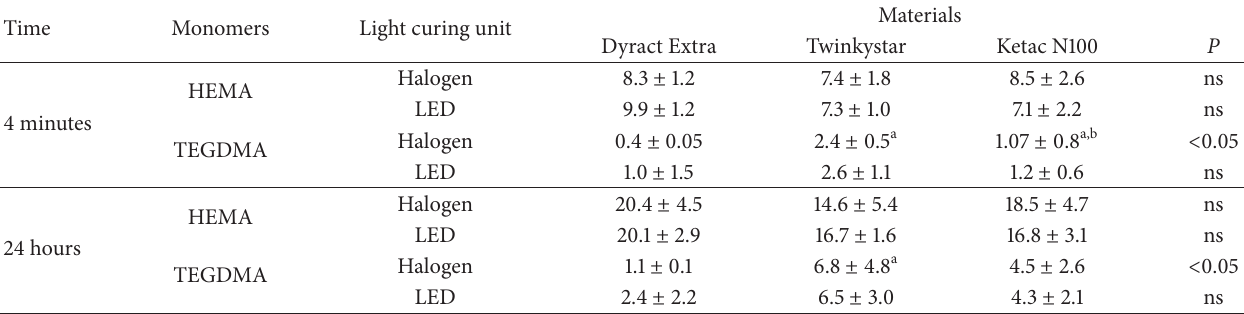
Table 2: The residual monomer concentrations eluted from resin modified glass ionomer cement and compomers cured with halogen and LED light curing units in different time periods (mean ± sd).